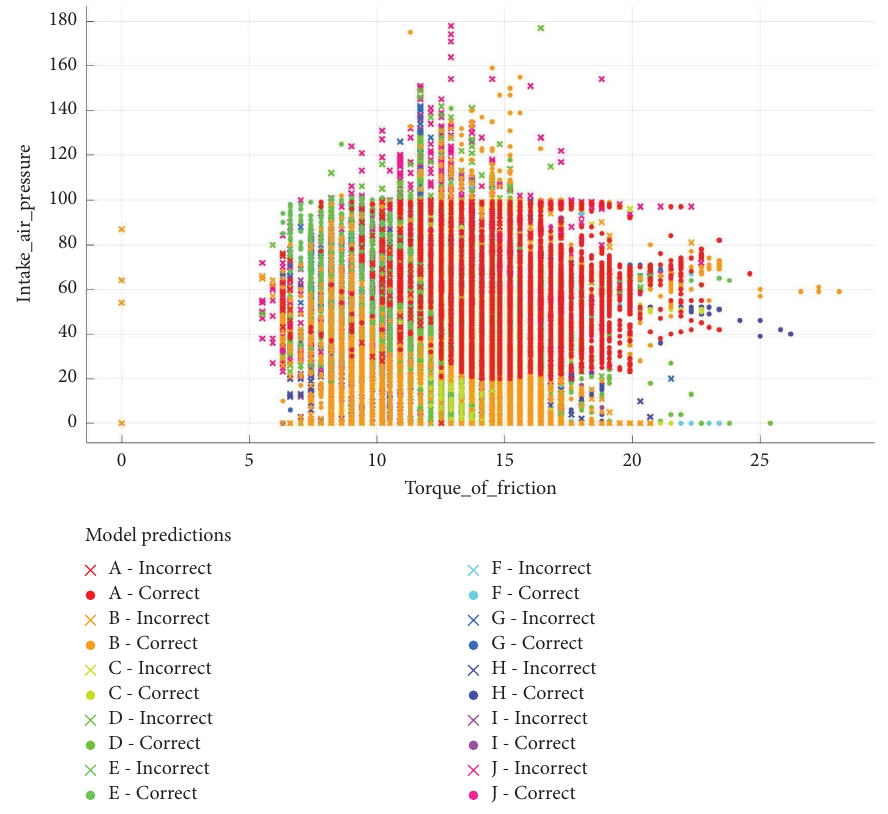
Figure 5: Model prediction with features torque of friction vs. intake air pressure.